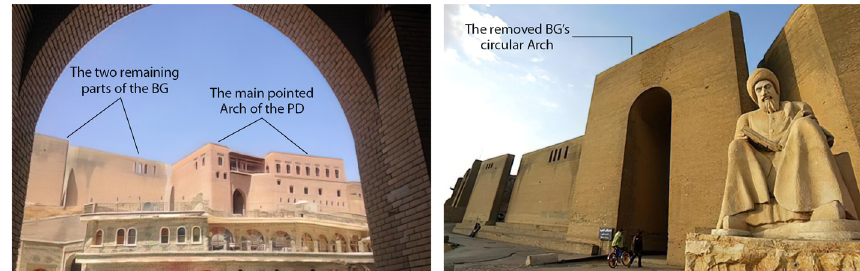
Fig. 1 Left: the PD ’ s pointed arch, 2017 (Source: the author). Right: supersedes the BG ’ s circular arch (Source: site archival